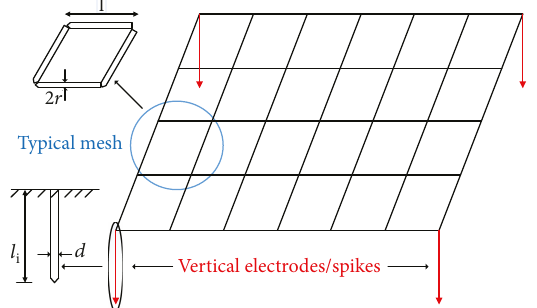
Figure 3: Three-dimensional view of the earthing system.